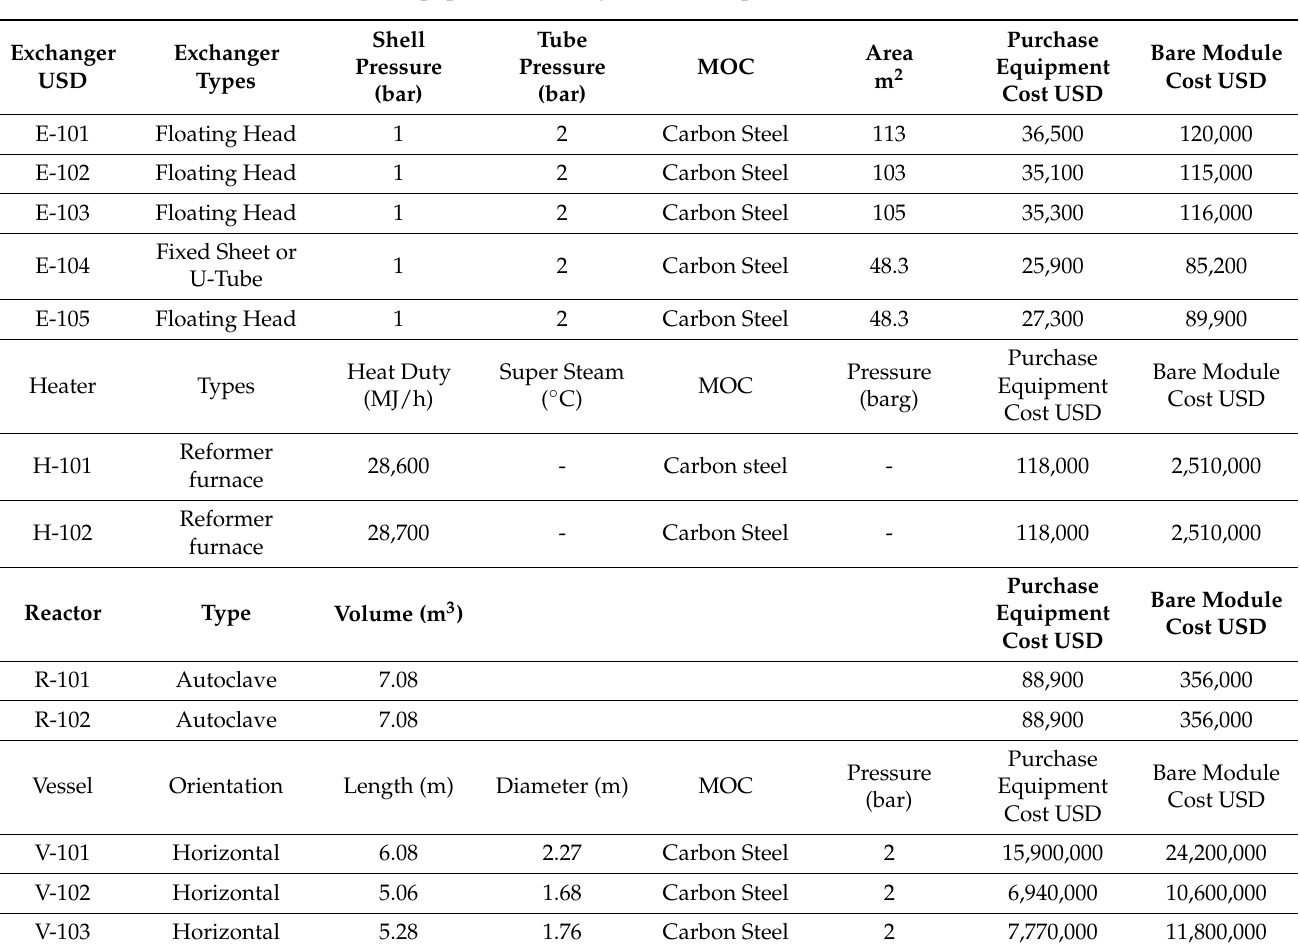
Table 9. Equipment summary of the Claus